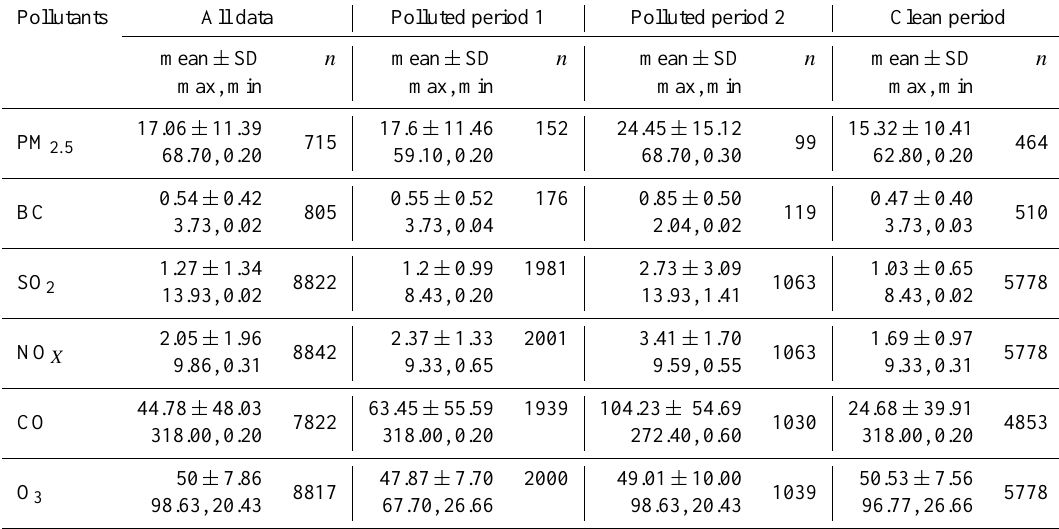
Table 1. Concentrations of six air pollutants during the sampling period, two pollution periods, and a clean period. Pollutants All data Polluted period 1 Polluted period 2 Clean period mean ± SD